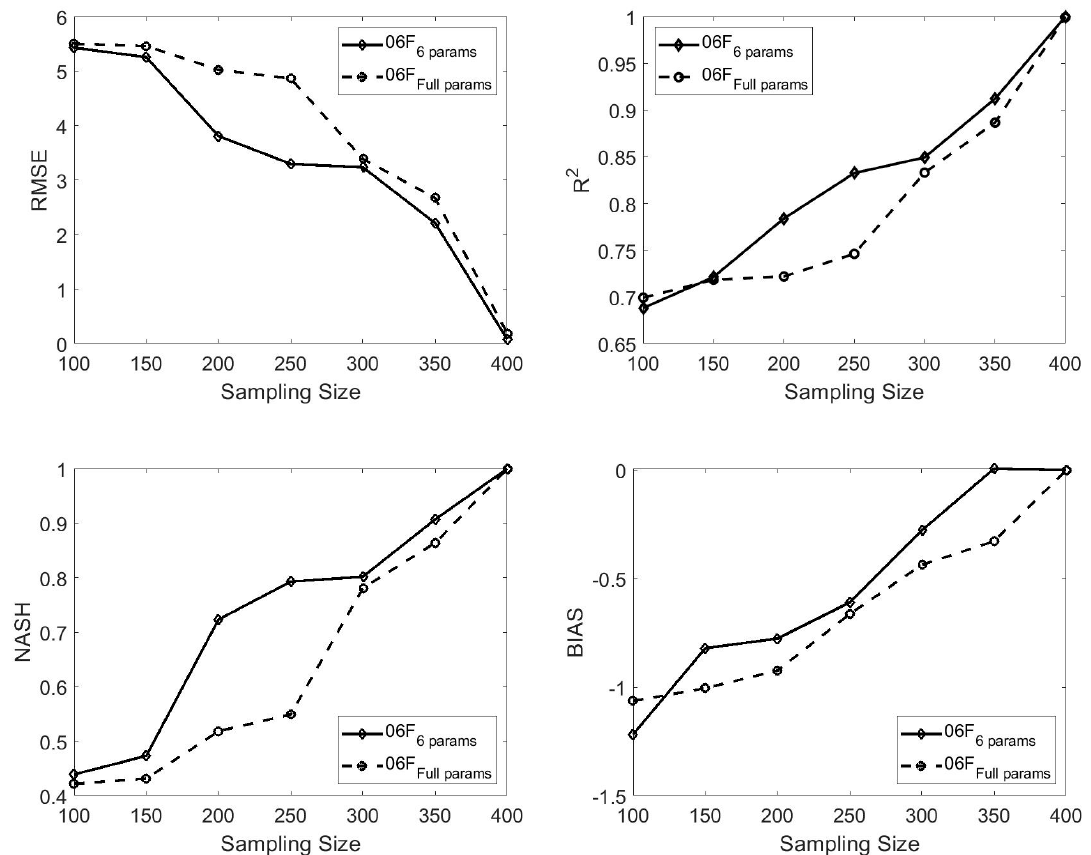
Figure 4. Results of the four statistical indices for the maximum displacement estimation using the six-floor building. Table 4. Statistical results for different parameters and various sampling sizes based on the six-floor building.